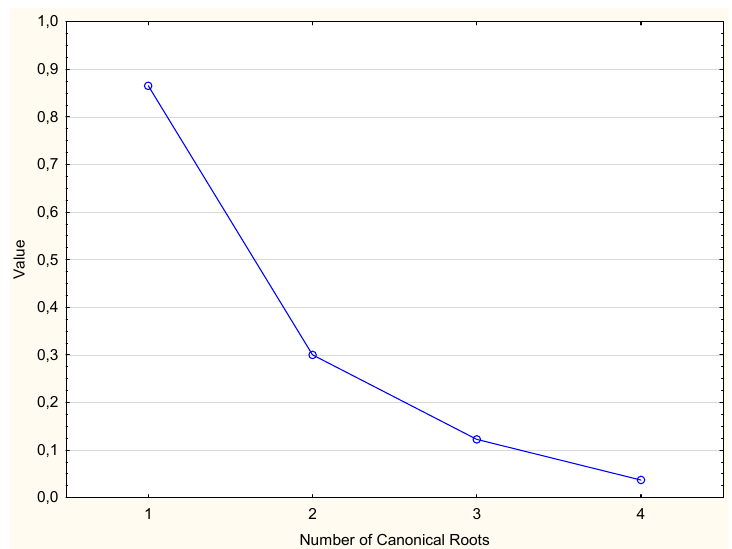
Fig. 4: Graph of eigenvalues corresponding to canonical roots Table 4: Canonical weights and variable loadings of the first canonical root Left Right